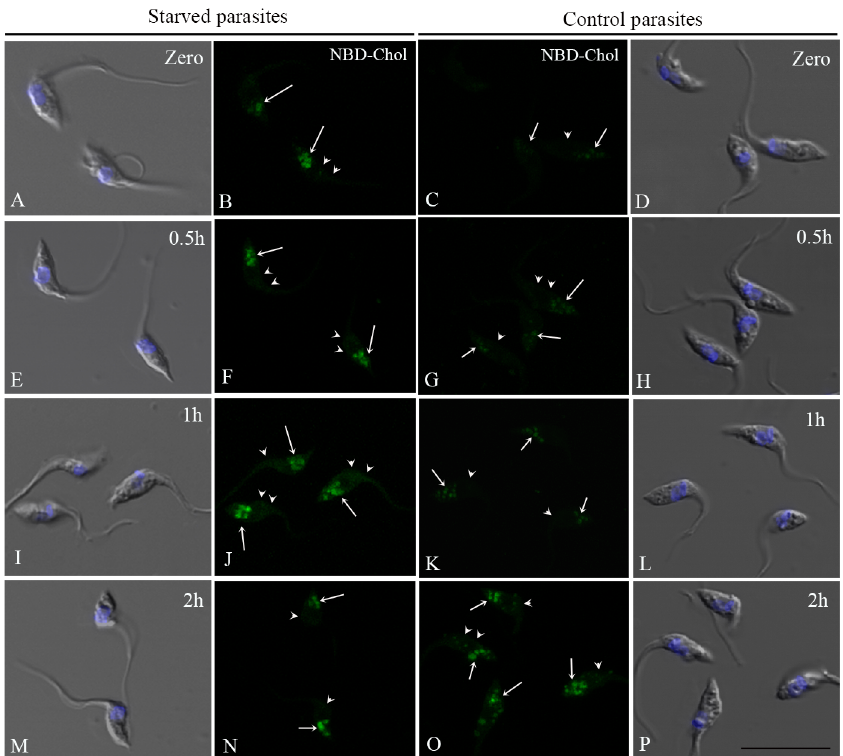
Fig 2. Distribution of NBD-cholesterol in T . cruzi epimastigotes. Starved and control parasites were incubated with LDL-NBD-cholesterol (1 mg/mL) for 30 min at 28°C, to concentrate the tracer in reservosomes, washed, resuspended in LIT + 10% FCS and chased for 0 h (A-D), 0.5 h (E-H), 1 h (I-L) and 2 h (M-P) for the fluorescent tracer distribution. Figures B, C, F, G, J, K, N and O are NBD fluorescence of formaldehyde fixed parasites, all registered under the same conditions. Figures A, D, E, H, I, L, M and P are overlays of DIC images and DAPI staining, used to label the nucleus and kinetoplast positions. The white arrows point to reservosomes and the arrowheads to the NBD-cholesterol in parasite membrane. Bar: 10 μ